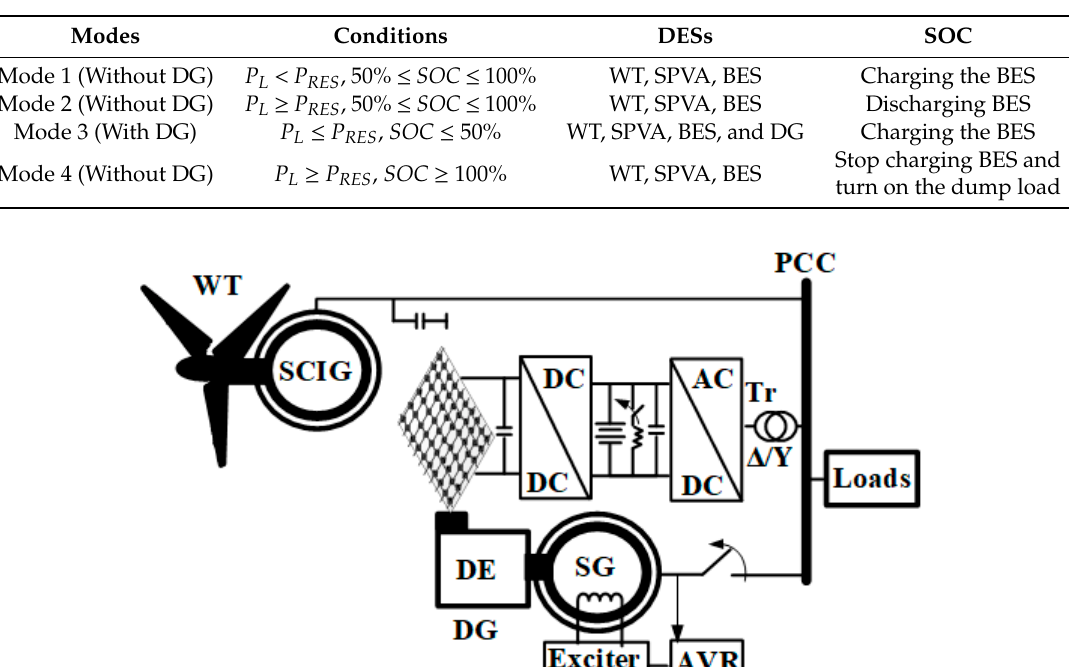
Table 1. Operation modes for off-grid configuration based on SPVA, DG, and WT.